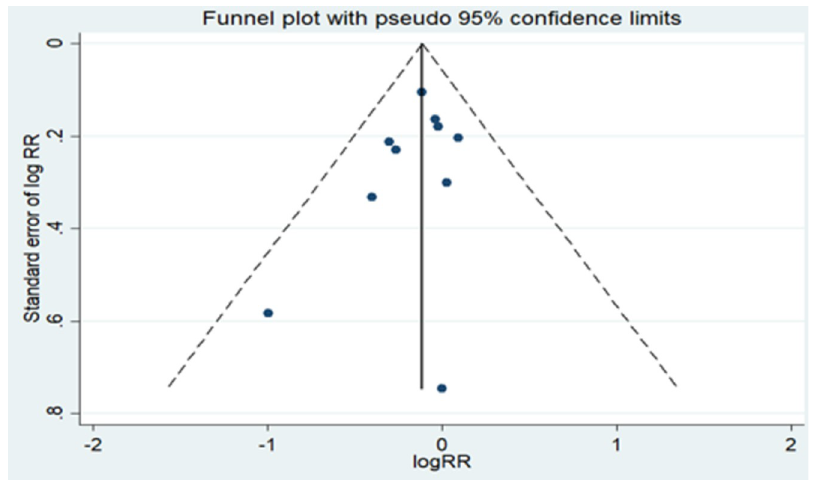
Fig 5. Funnel plot for publication